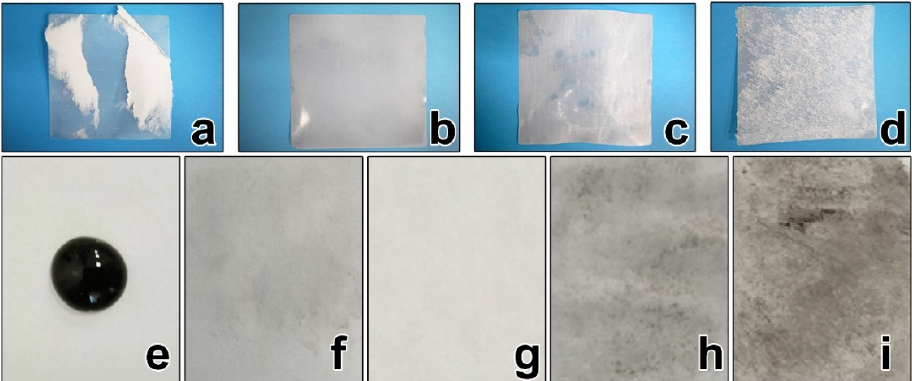
Figure 4. ( a–d ) Adhesive tape test. ( e ) Ink drop view and ( f–i ) ink drop test samples. Pre-coating layers: ( a,f ) PS suspension, ( b,g ) PEVA emulsion, ( c,h ) PVOH solution, and ( d,i ) CC solution.